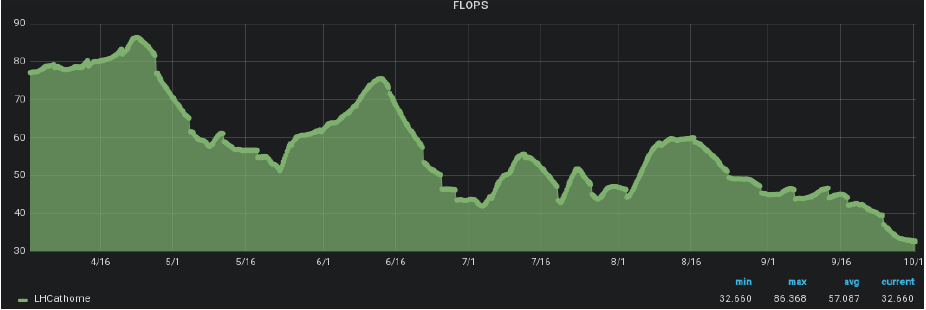
Figure 2. Volunteer computing power as a function of running